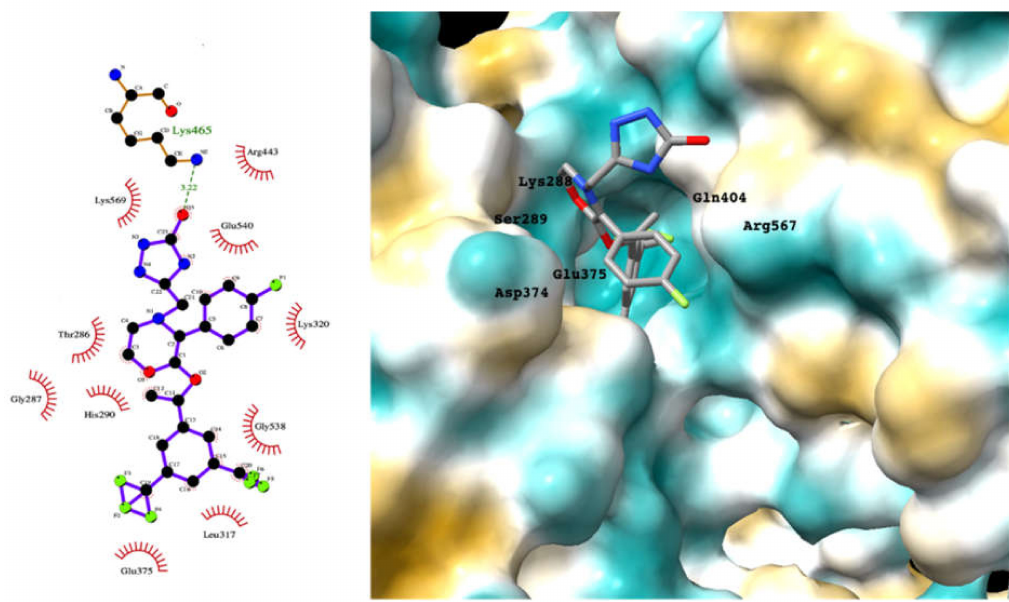
Figure 6. LigPlot ( left ) shows the key active site residues interacting with aprepitant. The molecular model ( right ) shows the binding of aprepitant to the active site cleft of the helicase. The molecular surface denotes hydrophobicity of the pockets (blue hydrophilic, yellow/brown hydrophobic). Positions of key binding site residues are labeled. Aprepitant (NK1 antagonist) buries the morpholino ether moiety in the hydrophilic pocket and the hydrophobic bis trifluoromethyl substituted ring even deeper into this pocket. The environment mismatch is compensated by the favorable π -stacking and π -cation interactions referred to